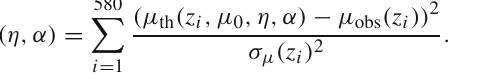
Table 5 Constraints on the interaction parameter η for different fluid interactions Types of